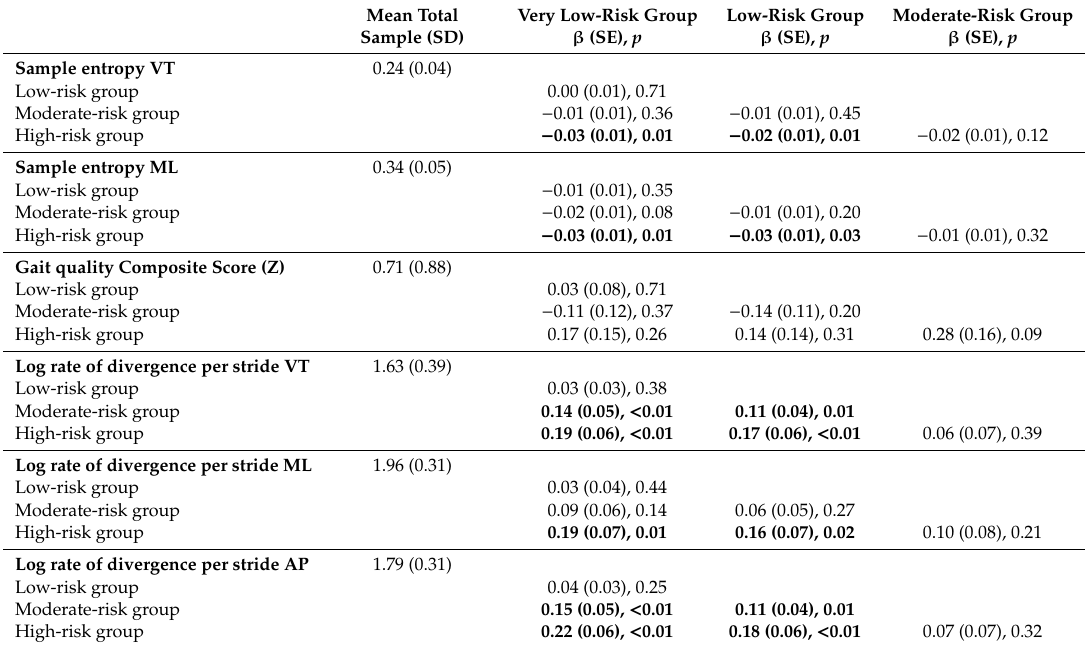
Table 2. Regression coe ffi cients ( β ) with standard errors (SE) for the linear regression models adjusted for walking